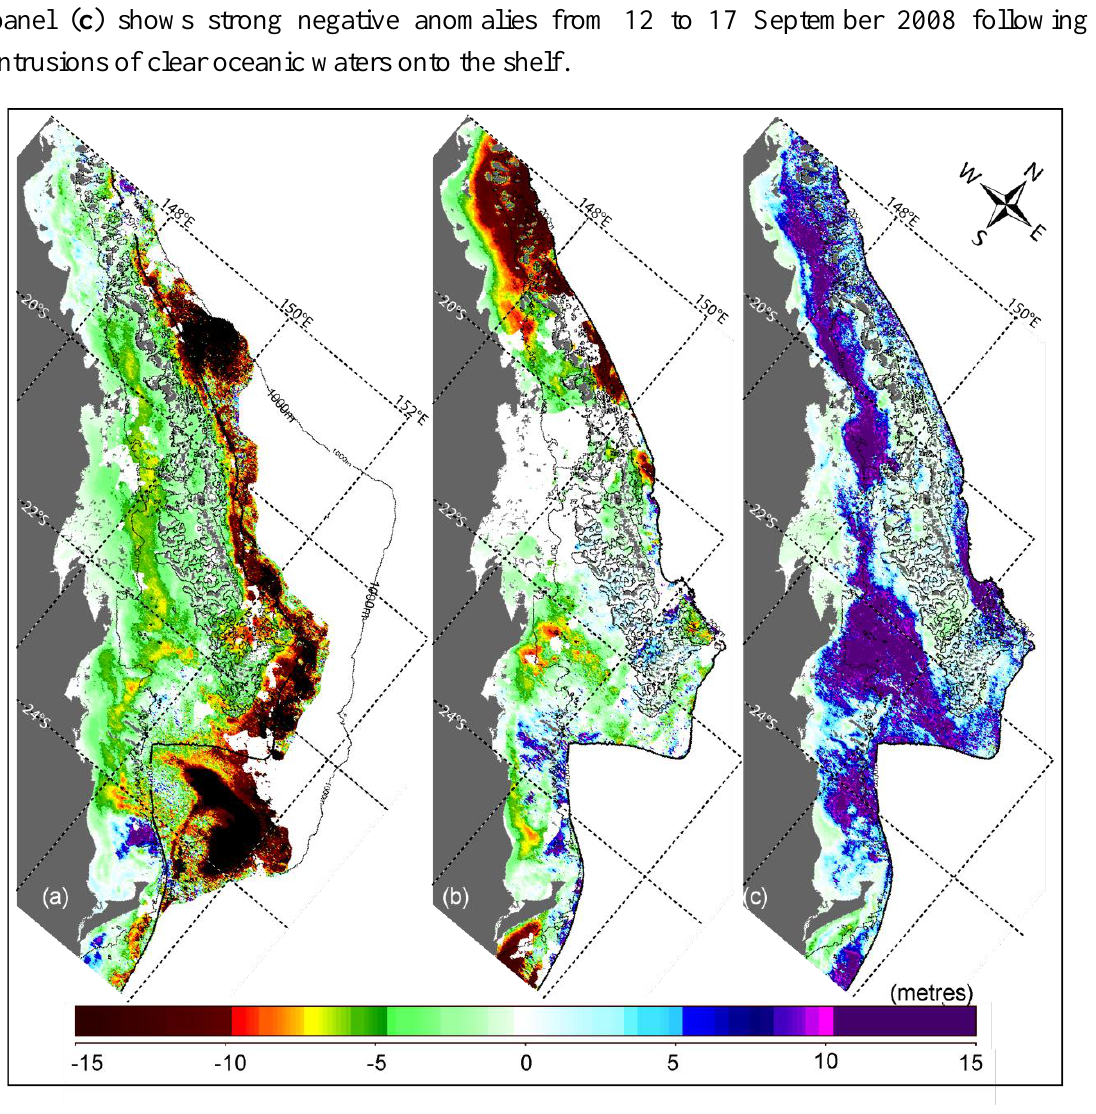
Figure 4. Secchi depth anomalies (m) on the central-southern Great Barrier Reef (panel orientations rotated by 40°). The dark and light black lines denote the 200 m and 1,000 m isobaths, respectively. Panel ( a ) shows intense positive anomalies and the turbid water track of Tropical Cyclone (TC) Hamish along the shelf edge from 14 to 17 March